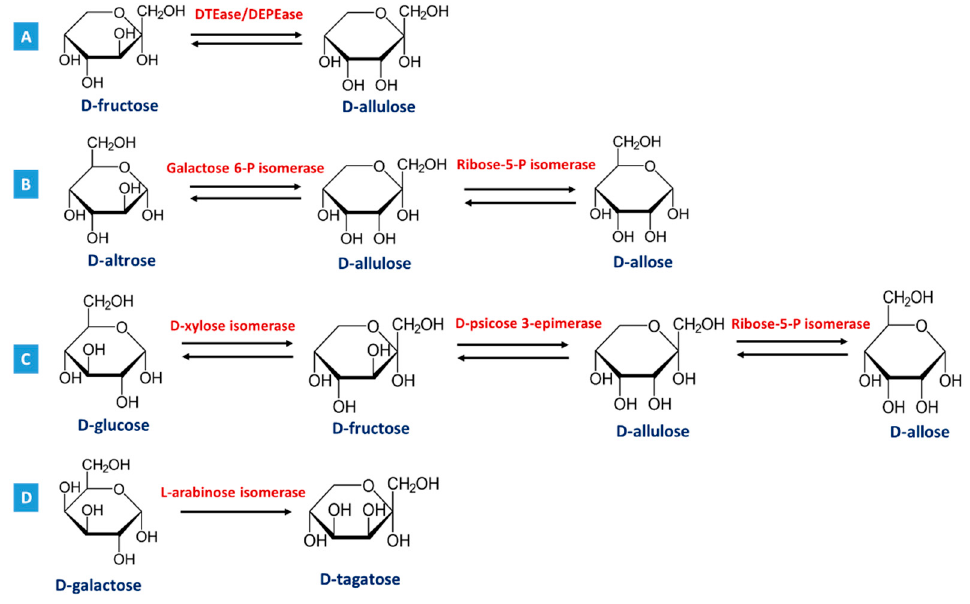
Figure 2. Enzymatic bioconversion of ( A ) D-fructose to D-allulose catalyzed by D-tagatose/D-psicose 3-epimerase (DTE/DPEase) enzymes; ( B ) D-allulose to D-allose, with or without D-arabinose as a byproduct when catalyzed by Galactose 6-phosphate isomerase or Ribose-5-phosphate isomerase, respectively; ( C ) D-glucose to D-allose sequentially catalyzed by D-xylose isomerase, D-psicose 3-epimerase, and ribose-5-phosphate isomerase; and ( D ) D-galactose to D-tagatose catalyzed by L-arabinose isomerase enzymes, according to Li et al. [11].